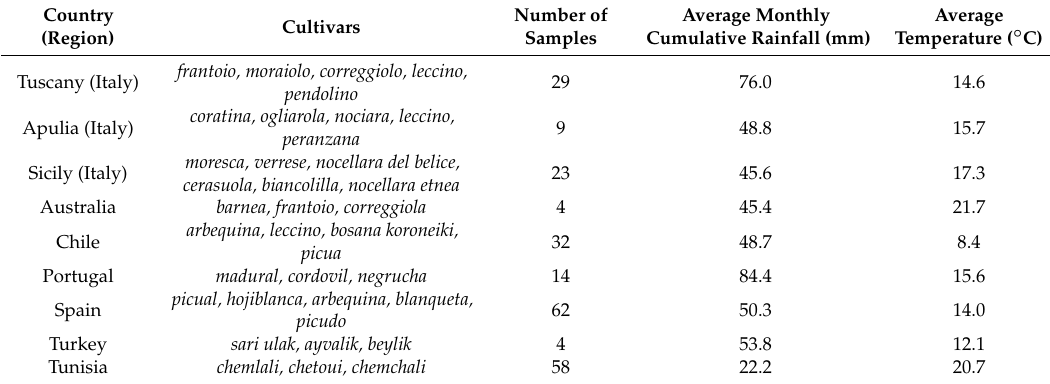
Table 1. Origins (from Italian regions and/or country), blend type and number of olive oil samples are reported in columns. Average of monthly cumulative rainfall (mm) and temperature ( ◦ C) are reported for each country and calculated over a four-year period